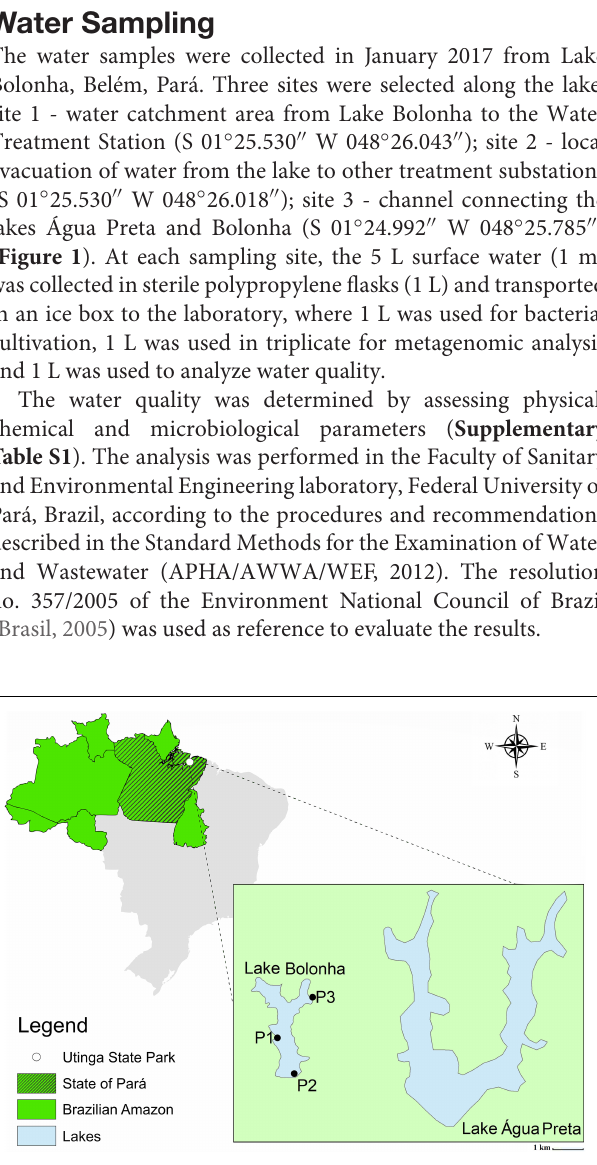
FIGURE 1 | Map of Lake Bolonha with the sampling sites